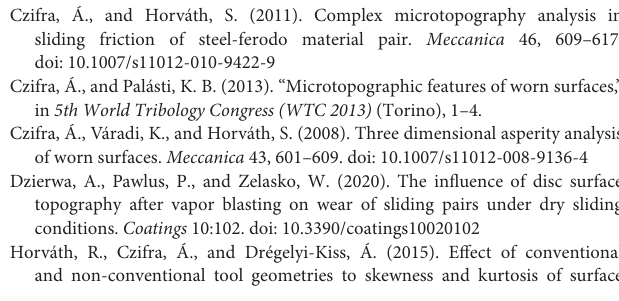
coarse and intensive groove formation is interconnected with higher Sdq and Sdr